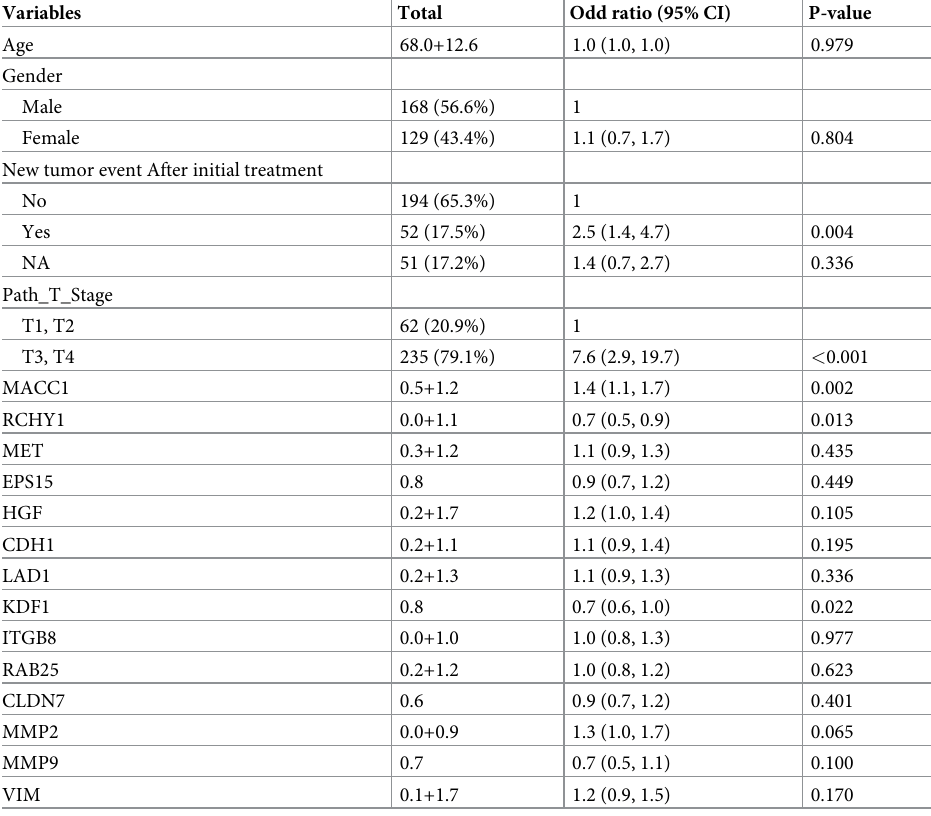
Table 2. Effects of risk factors on lymphatic metastasis by univariate analysis (N = 297).